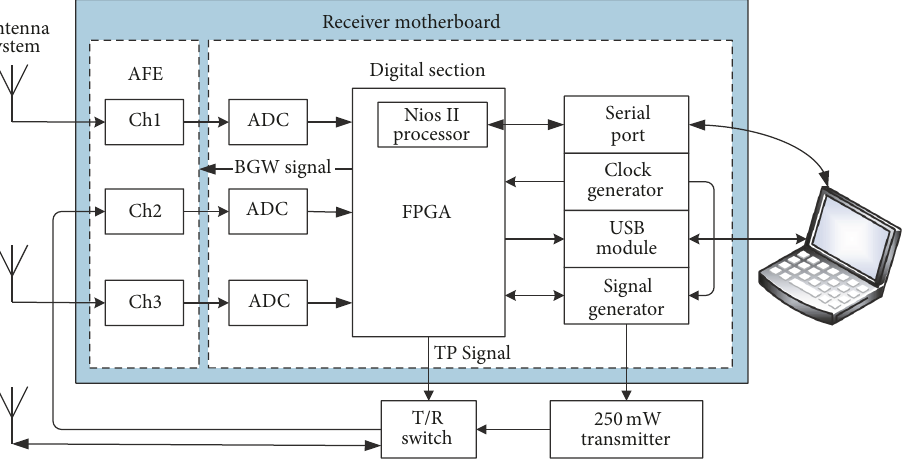
Figure 1: OSMAR-SU system structure.